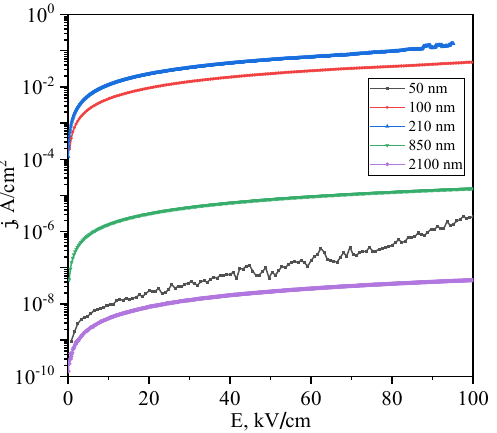
Figure 3. Current–voltage characteristics of ITO/co-PAEK/Cu heterostructures, measured at room Figure 3. Current – voltage characteristics of ITO/co-PAEK/Cu heterostructures, measured at room temperature, for different co-PAEK temperature, for different co-PAEK thicknesses.